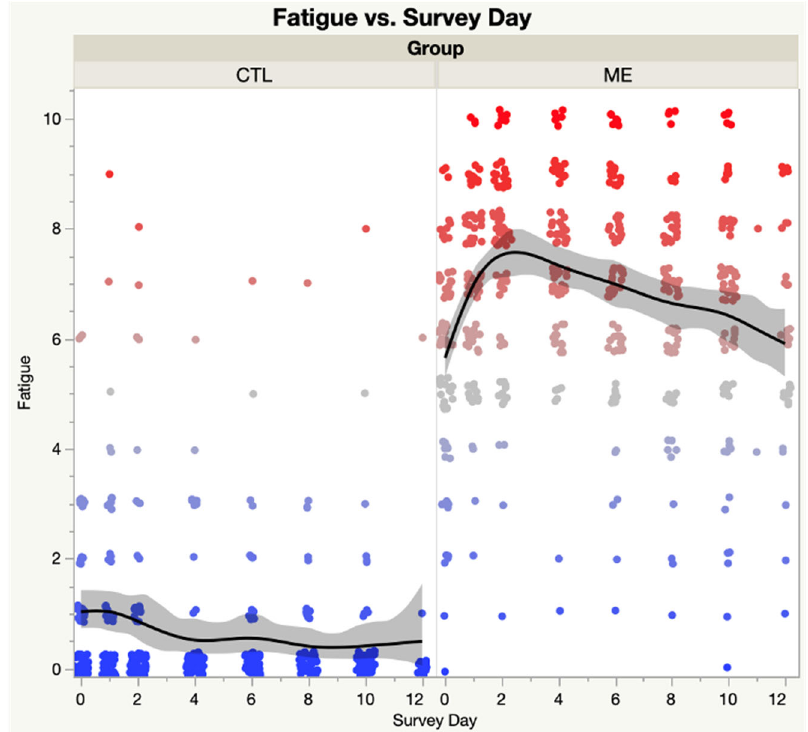
Figure 4. Fatigue domain score of SSS instrument—ME/CFS vs. CTL. Shaded area represents the 95% confidence interval. Each dot represents the PEM score for a single subject; Blue dots are low scores, red dots are high scores; Black lines represent the spline curves for group averages; Grey shaded areas are the 95% confidence intervals.